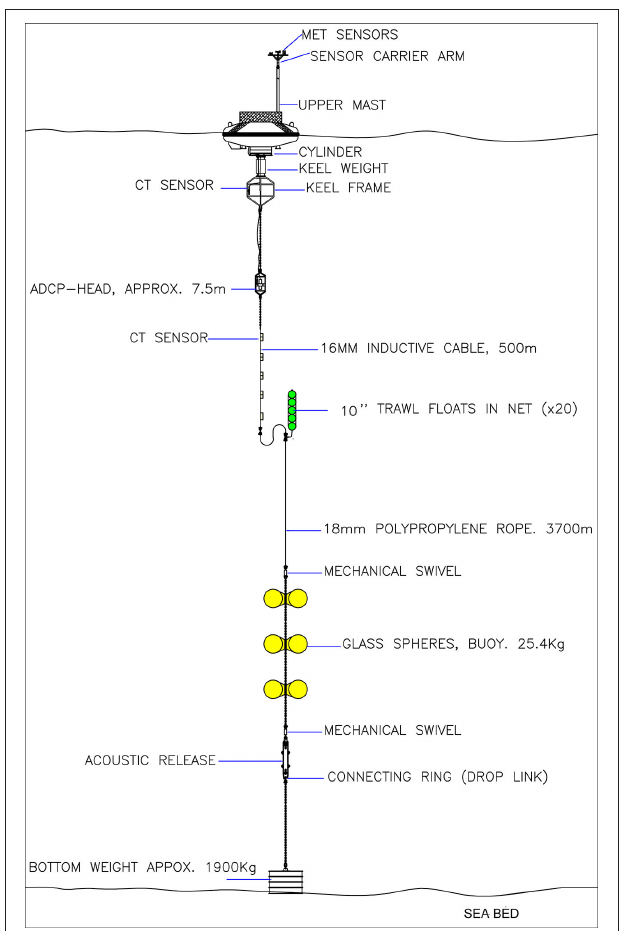
FIGURE 2 | OMNI buoy system